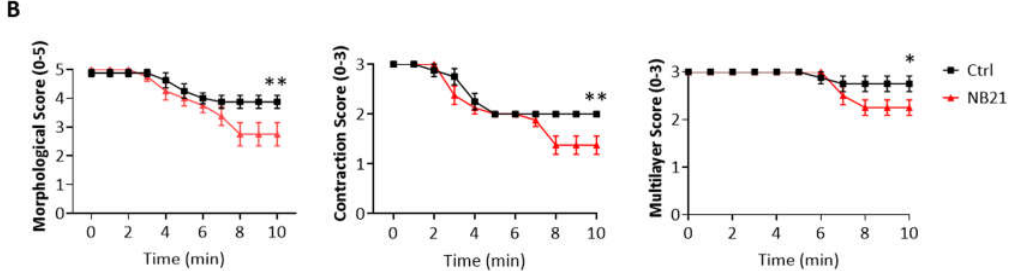
Figure 5. Blockage of GPVI with the anti-GPVI nanobody 21 (Nb21) causes minor thrombus instability. Recalcified blood was perfused for 7 min on Horm collagen at 37 °C at arterial shear (1000 s −1 ), and successively post-perfused for 10 min with rinse buffer and blocking anti-GPVI nanobody Nb21 (500 nM). ( A ) Representative images after perfusion of blood from 6 donors, taken during post-perfusion at time 0, 5 and 10 min. ( B ) Graphs showing extent of disaggregation, monitored from recorded brightfield images every min, and measured as morphological, contraction and multilayer scores [16]. Scale bar = 50 µm. Data are shown as mean+s.e.m. * p < 0.05, ** p < 0.005 one-tailed Student’s paired t -test.